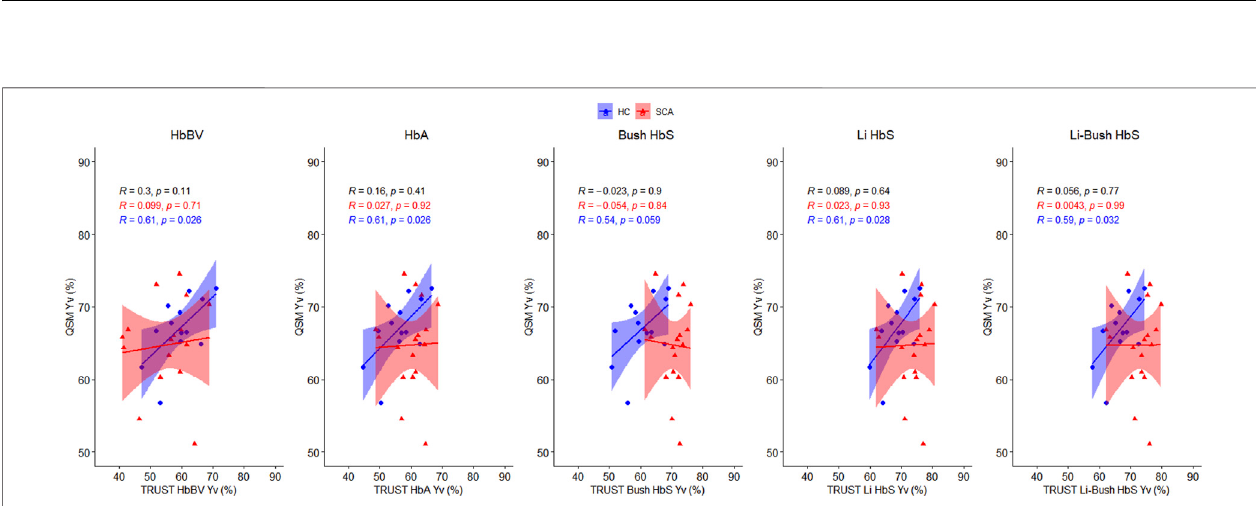
FIGURE 3| Correlation between QSM and TRUST-based measures of venous oxygen saturation (Y v ) in sickle cell anemia (red) and healthy control subjects (blue). Pearson ’ scorrelationcoef fi cients(r),andthecorresponding p values,areshownforthecombinedcohort(black),andfortheSCA(red)andhealthycontrol(blue)groups. Shaded areas indicate the 95% con fi dence intervals of the linear